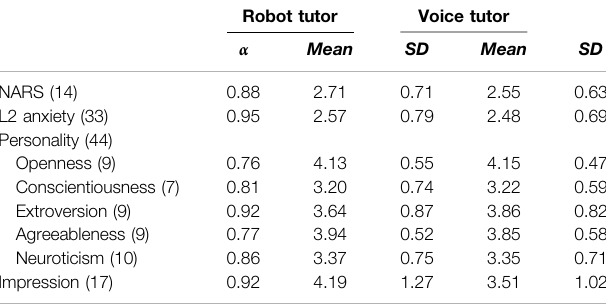
TABLE 2 | Descriptive statistics for the individual difference